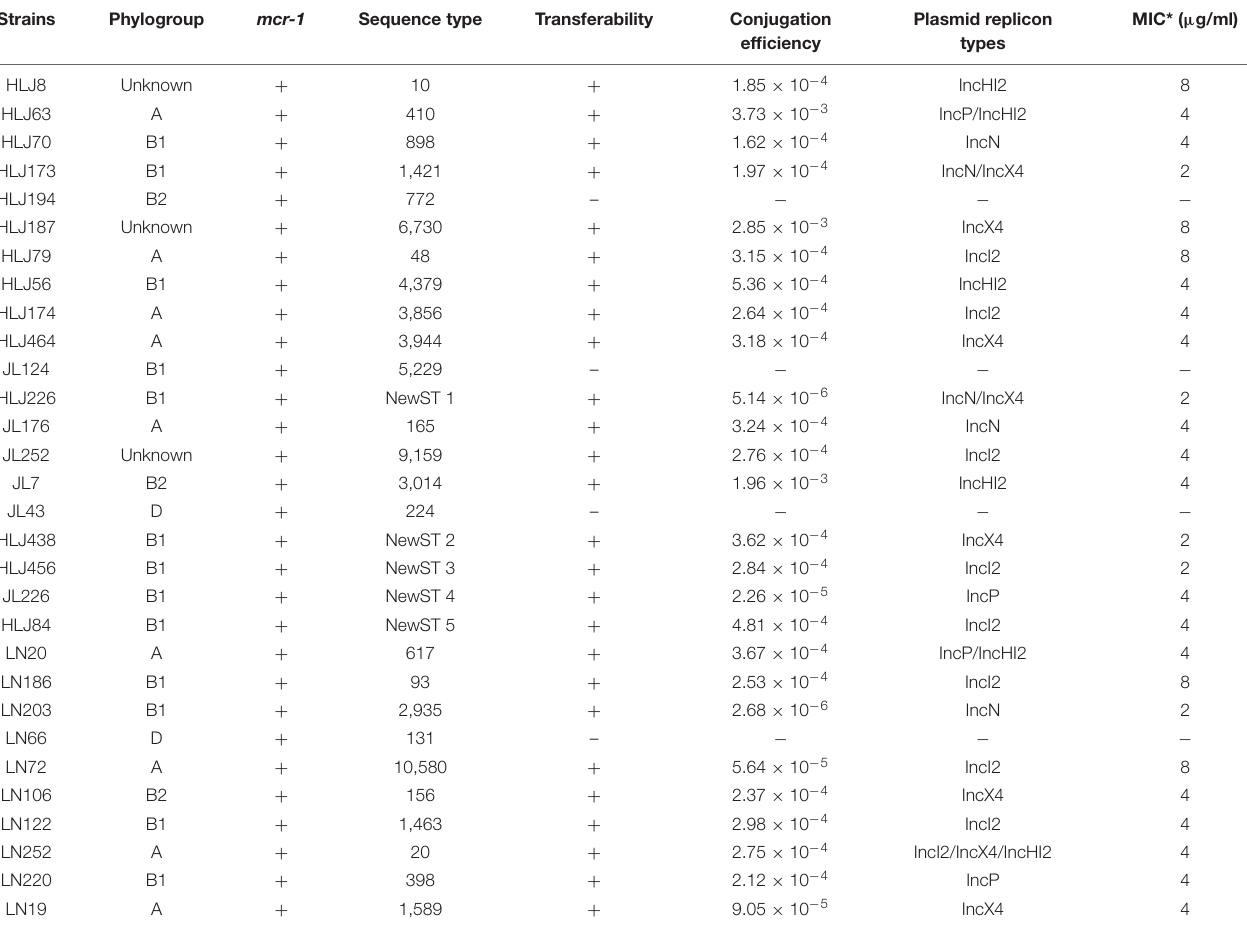
FIGURE 5 | Biofilm formation ability of mcr-1 -positive E. coli ; the red indicates increased biofilm formation ability, and green indicates decreased biofilm formation ability compared with E. coli ATCC 25922. ∗ p < 0.05; $ p < 0.01. TABLE 3 | MLST, transferability, conjugation efficiencies, and plasmid replicon types of 30 mcr-1- positive E. coli.